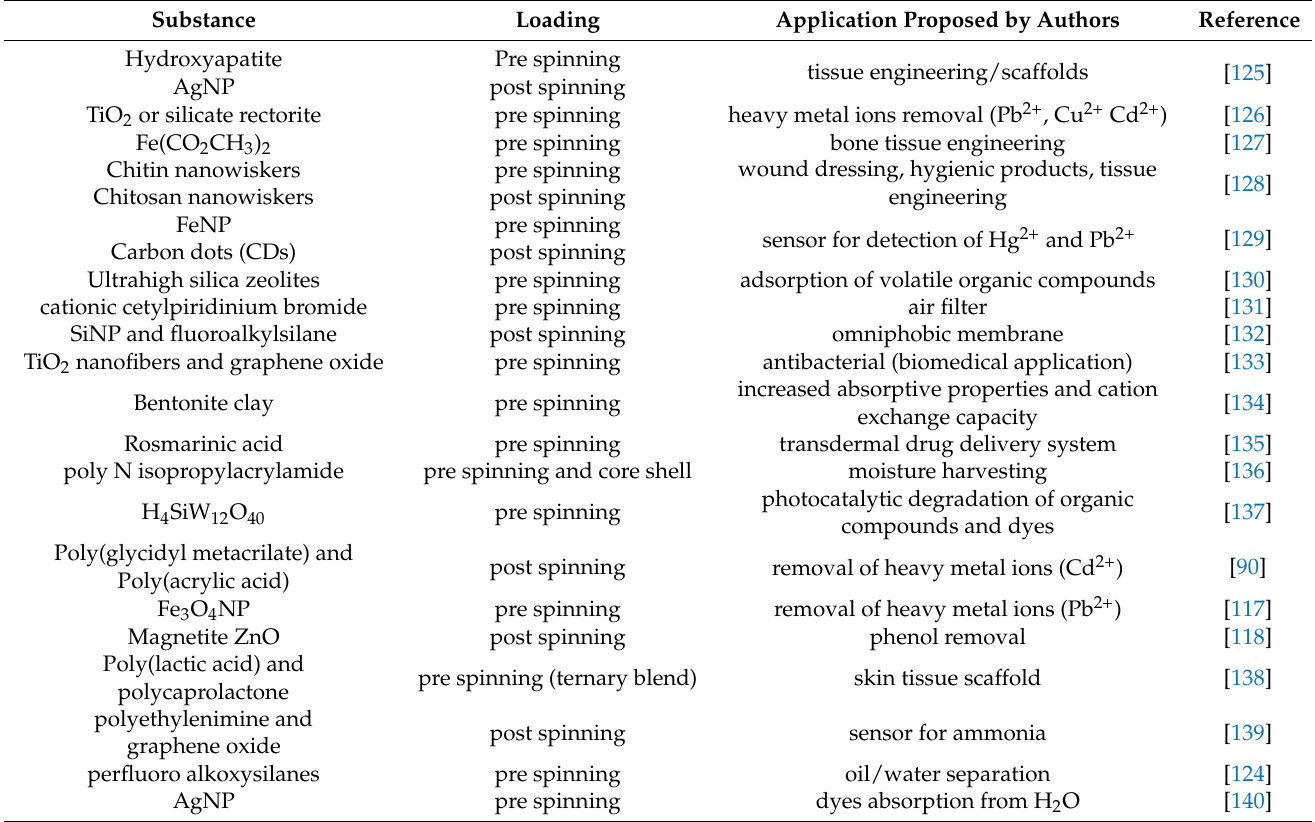
Table 5. Electrospun cellulose acetate with various additives for special